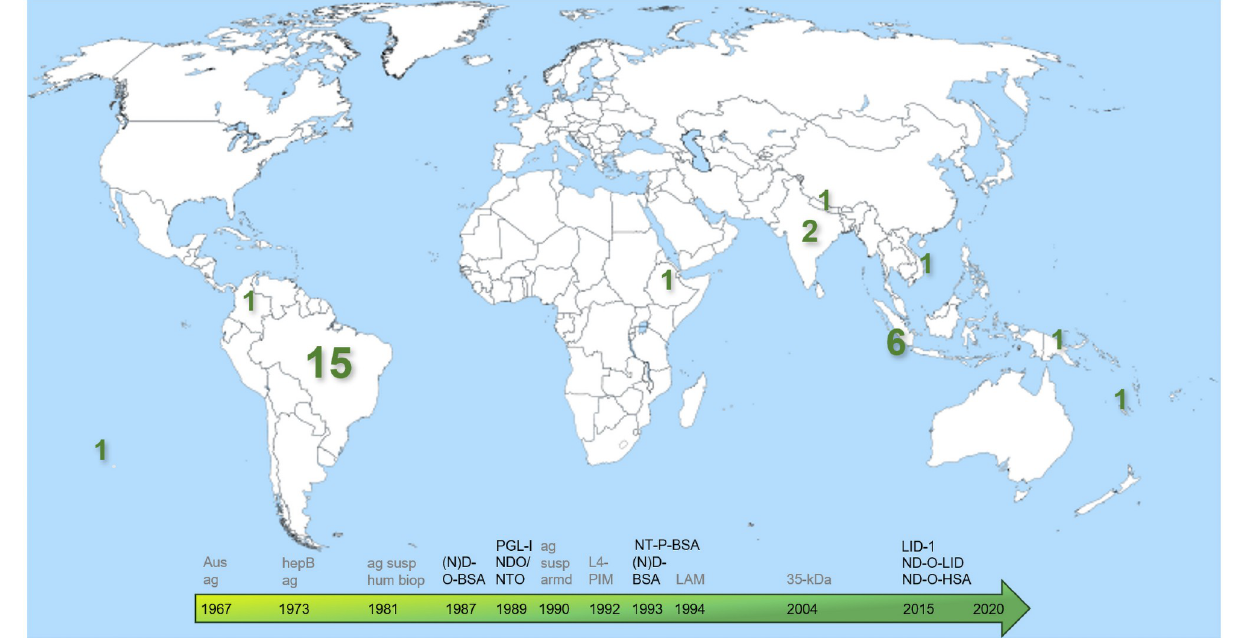
Fig 2. Leprosy serology in children without leprosy. Schematic representation of the countries where the selected studies in this review were located. The green numbers indicate the number of studies per country. The arrow indicates the chronological use of target antigens applied for leprosy serology. The antigens colored in grey, are those used in studies reporting leprosy serology among children without leprosy, which did not fulfil all inclusion criteria of this review. Aus ag: Australia antigen; hepB ag: hepatitis B antigen; ag susp hum biop: antigen suspension prepared from human leprosy biopsy tissue; ag susp arm: suspension of M . leprae purified from an infected armadillo’s liver; (N)D-O-BSA: (natural) disaccharide-octyl bovine serum albumin; PGL-I: phenolic glycolipid I; NTO: natural trisaccharide-octyl; L4-PIM: L4-reactive antigen from M . tuberculosis ; NT-P-BSA: natural trisaccharide phenylpropionyl bovine serum albumin; LAM: lipoarabinomannan; 35-kDa: 35-kilodalton protein of M . tuberculosis ; LID-1: leprosy IDRI diagnostic-1; ND-O-LID: semi-synthetic disaccharide attached to the octyl radical, which mimics PGL-I, conjugated with two fusion proteins, ML0304 and ML0331, forming LID; ND-O-HSA: natural disaccharide-octyl human serum albumin. The template for this world map was retrieved from: https://www.worldofmaps.net/weltkarten/weltkarten-und-weltatlas/weltkarte-blank-vektorgrafik.htm. Colored numbers and a timeline were